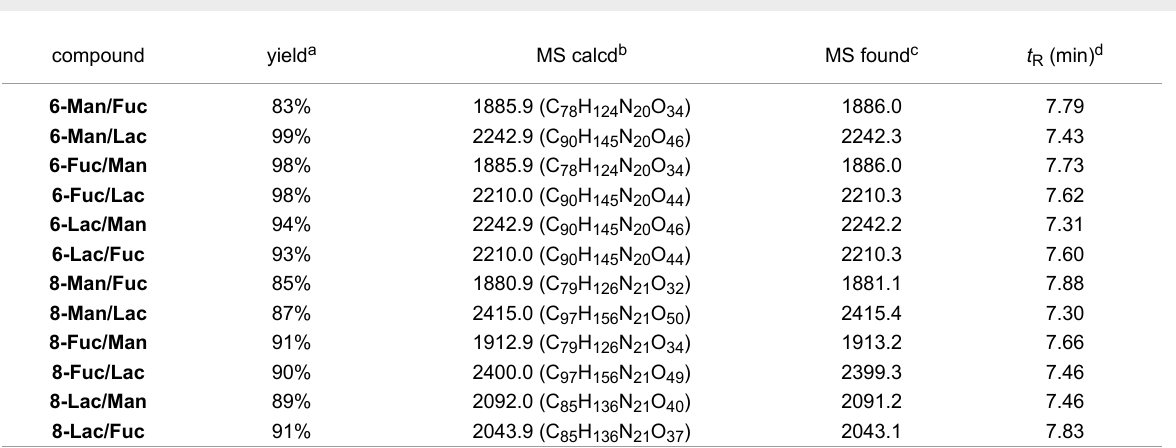
Table 1: Outcome of the orthogonal ligation procedure.